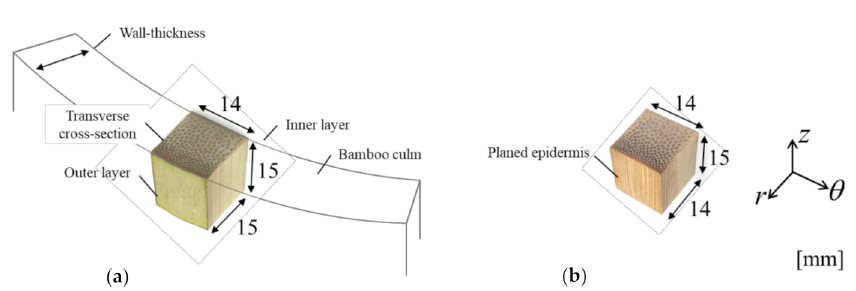
Figure 1. Schematic illustration of specimen sizing: ( a ) with epidermis and ( b ) with planed epidermis. In the first batch, cubed specimens, with their outer epidermis removed, had average dimensions of 15 mm (longitudinal) × 14 mm (tangential) × 14 mm (radial). A second batch of bamboo specimens similar to the cubed dimensions was considered in the investigation by taking into account their outermost epidermis layer. This batch of cubed specimens was sized based on full wall thickness and had average dimensions of 15 mm (longitudinal) × 14 mm (tangential) × 15 mm (radial). A total of 10 specimens were investigated in each batch A and batch